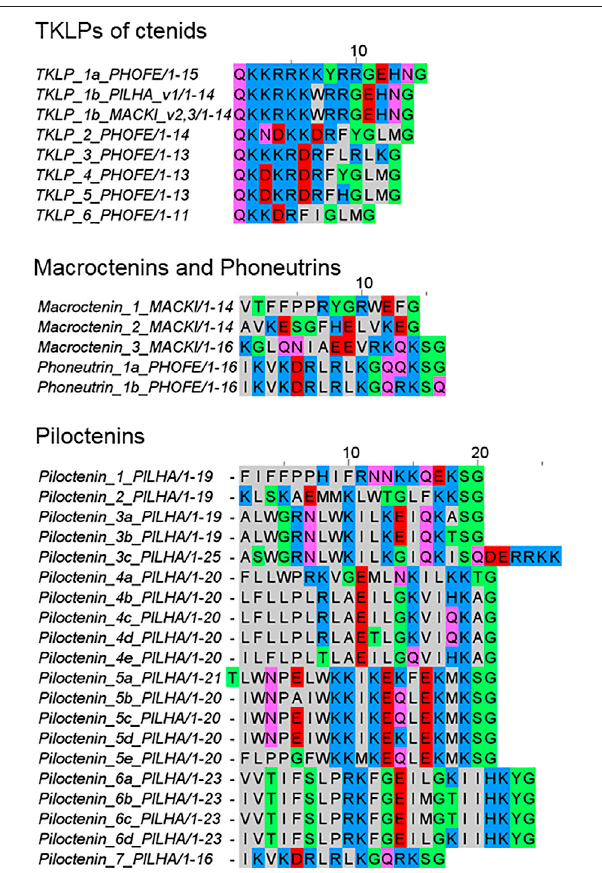
FIGURE 8 | Overview of tachykinin-like peptides (TKLPs) and short LPs (macroctenins, phoneutrins, and piloctenins), identi fi ed in the venom gland transcriptomes of ctenids. PHOFE: Phoneutria fera , MACKI: Macroctenus kingsleyi , PILHA: Piloctenus haematostoma . Cationic amino acids are coloredinblue,anionicaminoacidsinred,thecorrespondingC-terminalamid variants in pink, hydrophobic amino acids in black, and polar amino acids in